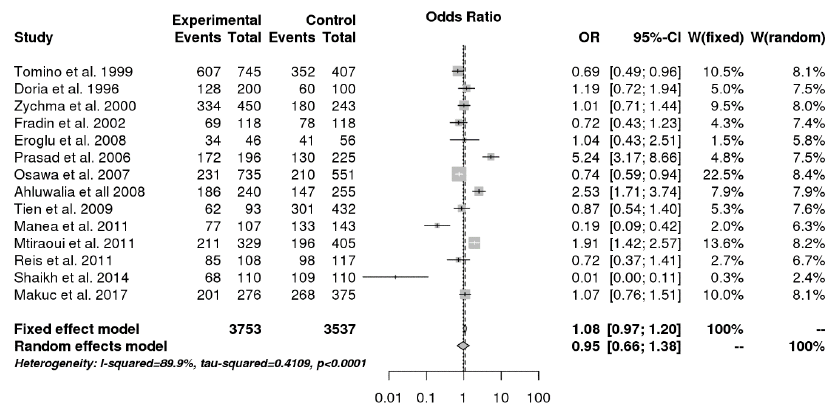
Figure 2. Forrest plot of dominant model for overall comparison of AGT M235T polymorphisms and